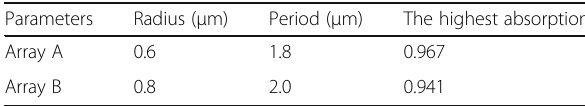
Table 3 Parameters of arrays in Fig.